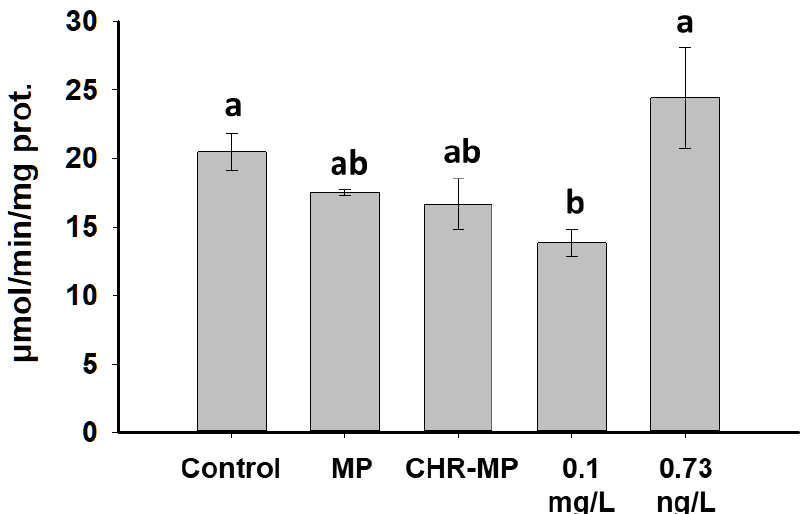
Figure 4. AChE specific activity (mean ± SEM, n = 3) measured in mussel gills after 7 days of exposure to 5 × 10 3 units/L of polystyrene microplastics (MP) and chrysene-loaded microplastics (CHR-MP), 0.1 mg/L and 0.73 ng/L of freely dissolved CHR (without MP). Different letters denote statistically significant differences ( p < 0.05, ANOVA — Bonferroni post-hoc comparison) among treatments.